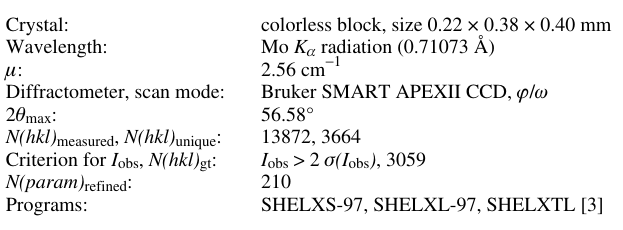
Table 1. Data collection and handling.